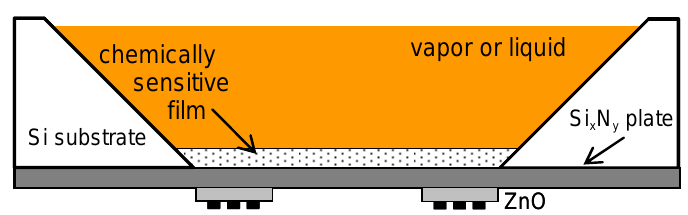
Figure 17. Scheme of a FPW